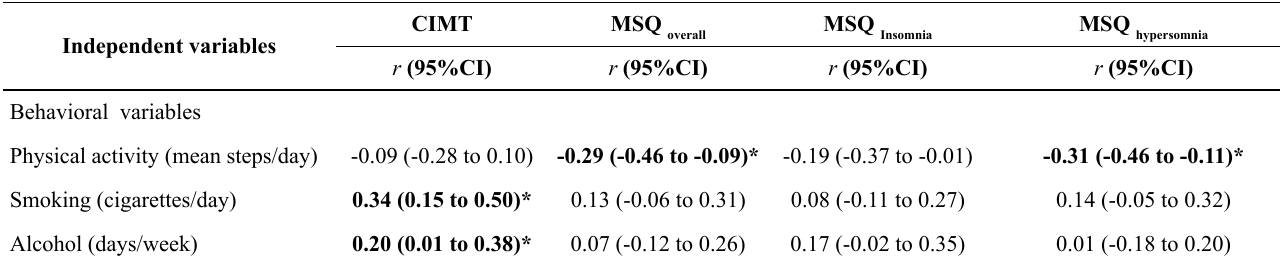
Table 2. Relationship between intima-media thickness, sleep and metabolic, inflammatory, behavioral variables among young adults.